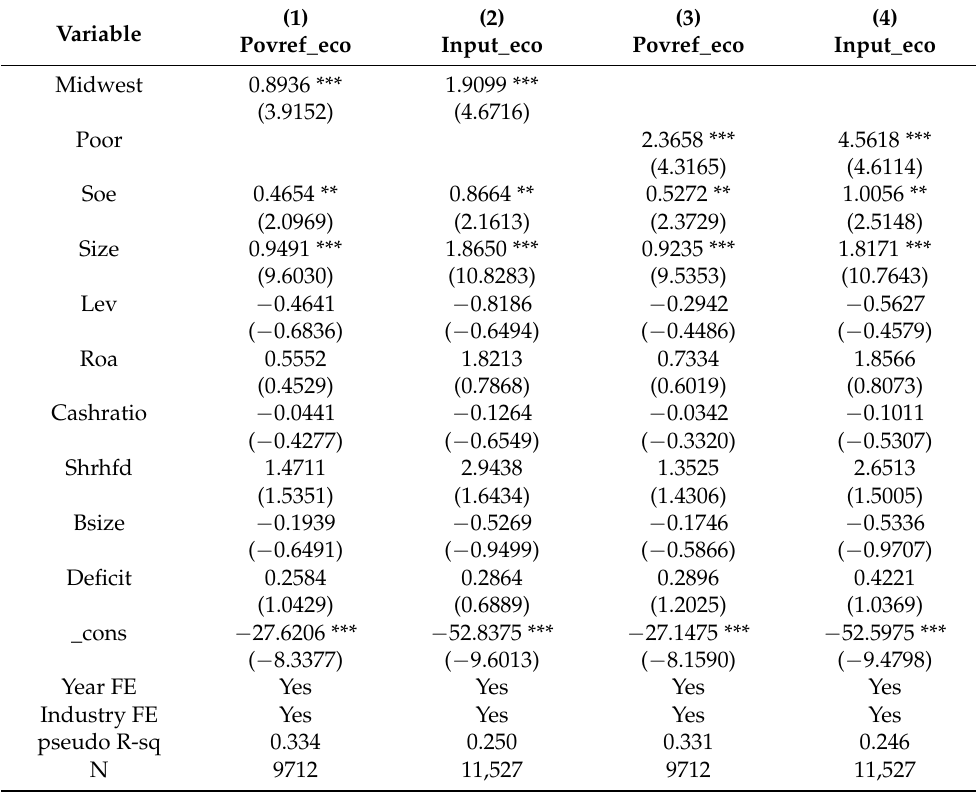
Table 4. The impact of the importance of poverty alleviation assessment on enterprise ecological poverty